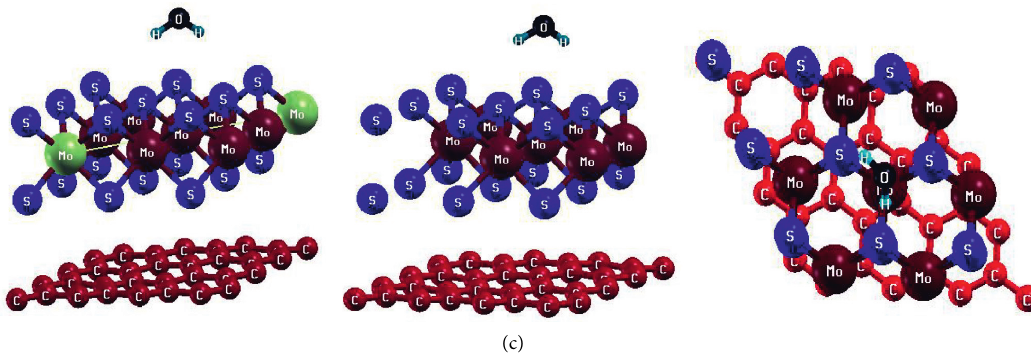
Figure 2: Side view and top view of Mo site vacancy defect HS materials: (a) center-1Mo atom vacancy defect water-adsorbed G/MoS (system-IIa), (b) left-1Mo atom vacancy defect water-adsorbed G/MoS 2 HS (system-IIb), and (c) 2Mo atoms vacancy defects water- adsorbed G/MoS 2 HS